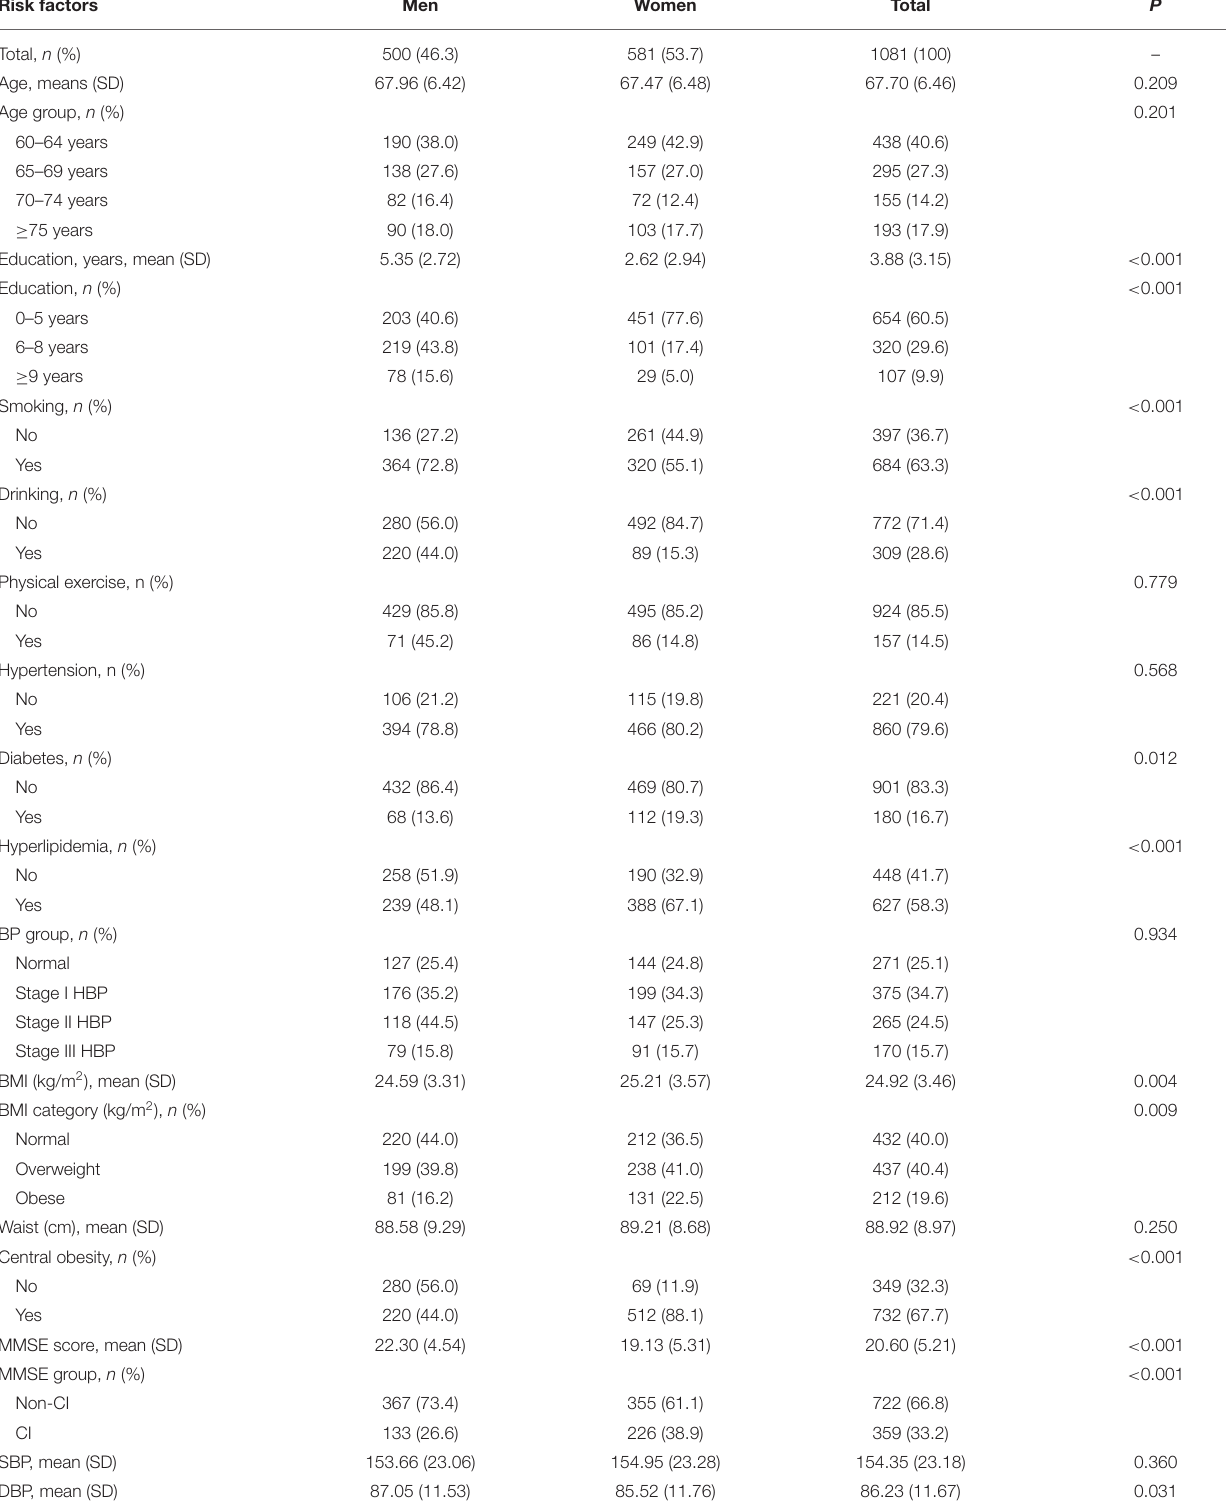
TABLE 1 | Demographic characteristics and risk factors for all participants by sex